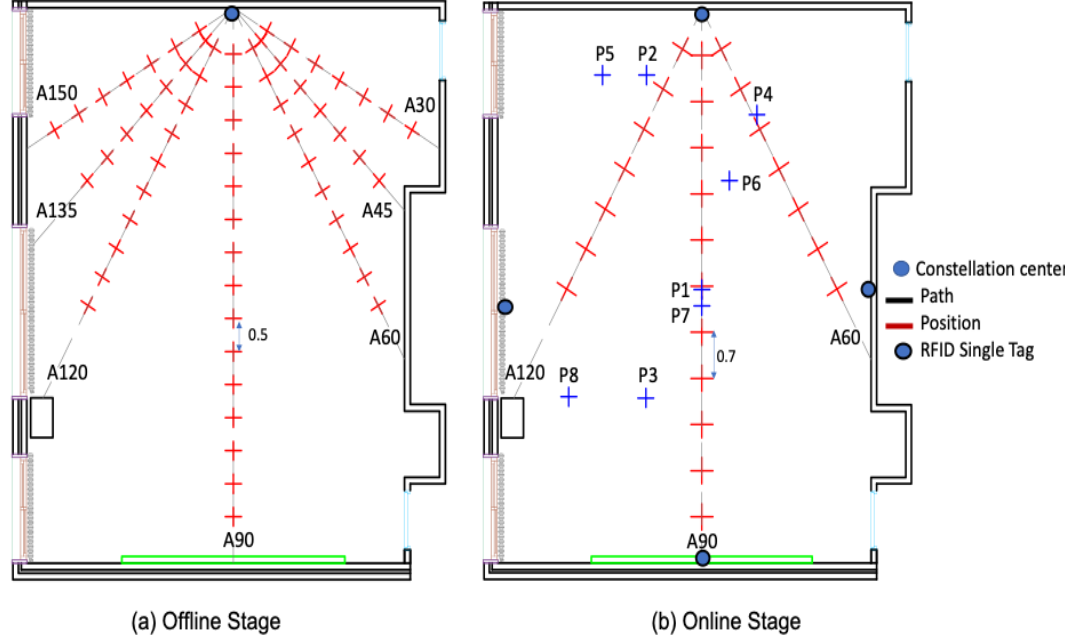
Figure 12. Two-dimensional layout of the classroom environment (offline and online stages).